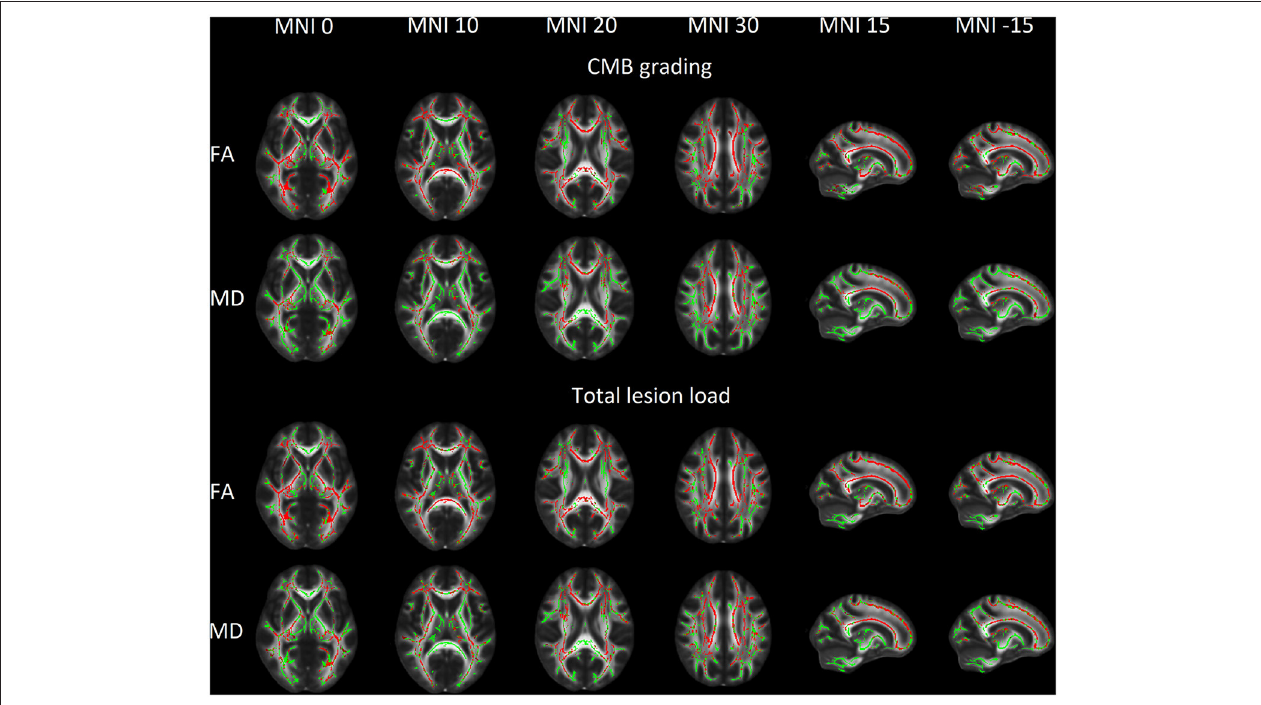
FIGURE 2 | Voxels with a significant linear association between cerebral microbleeds (CMB) and white matter microstructural properties shown in red overlaid on mean fractional anisotropy (FA) skeleton (shown in green) and Oxford Center for Functional MRI of the Brain mean FA template in Montreal Neurological Institute 152 (MNI) space. CMBs show a positive association with FA and a negative association with